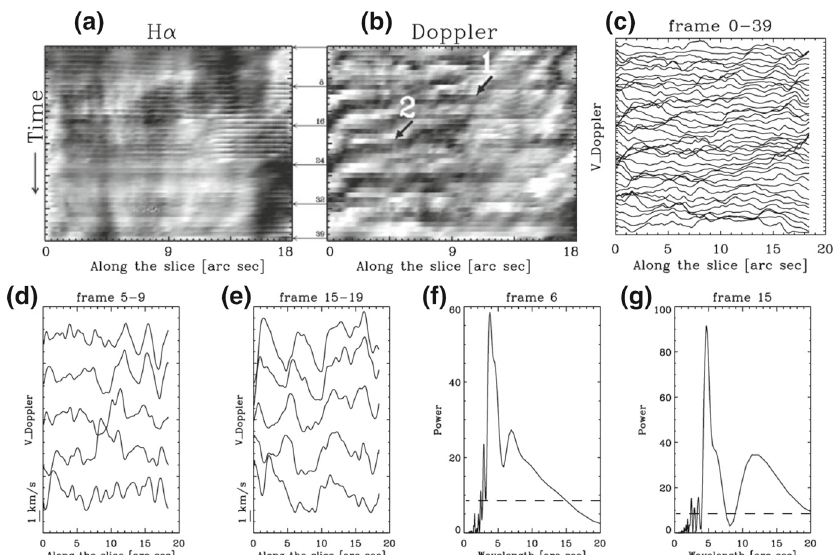
Fig. 32 a , b Time-slice diagrams of the H α line intensity and Doppler shift along a filament thread. c Data of b shown as a set of curves instead of as a contour plot. Each curve represents the Doppler velocity along the thread for a fixed time (frame). d , e Signals from c for some selected times (frames). f , g Power spectrum of the Doppler shift along the thread for two times. Large peaks help identify the wavelength of propagating oscillations. Image reproduced with permission from Lin et al. (2007), copyright by